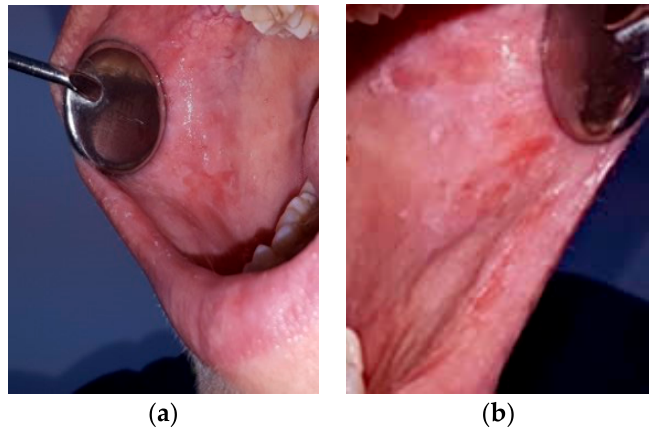
Figure 2. Chronic keratosis (Morsicatio buccarul) in a 17-year-old girl: ( a ) keratotic lesion on the oral mucosa of the right cheek; ( b ) keratotic lesion on the oral mucosa of the left cheek.